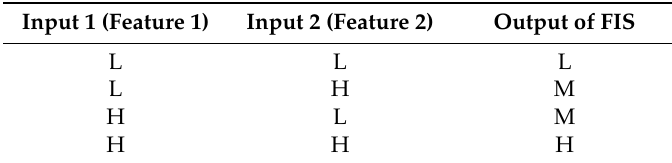
Figure 10. Output membership functions. Table 2. Fuzzy rules based on features 1 and 2.